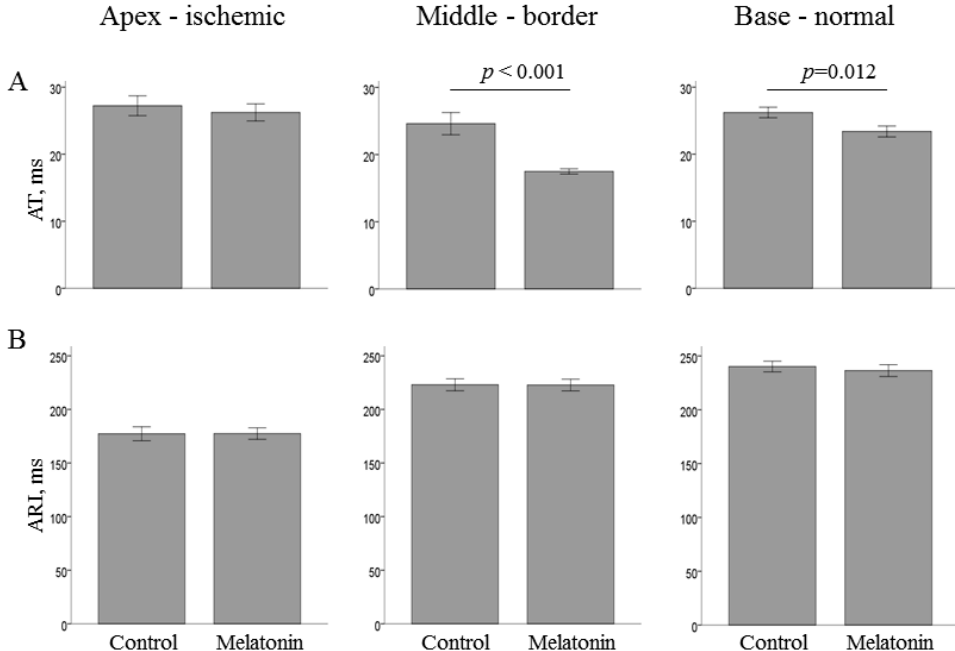
Figure 5. Effects of melatonin administration on local activation times (AT, panel A ) and activation–repolarization in- tervals (ARI, panel B ) in the ischemic (apex), border (middle part) and normal (base) regions of the left ventricle under coronary occlusion. Data are averaged over the period after 1 min from occlusion onset (time of melatonin infusion) until the end of ischemic exposure (mean ±